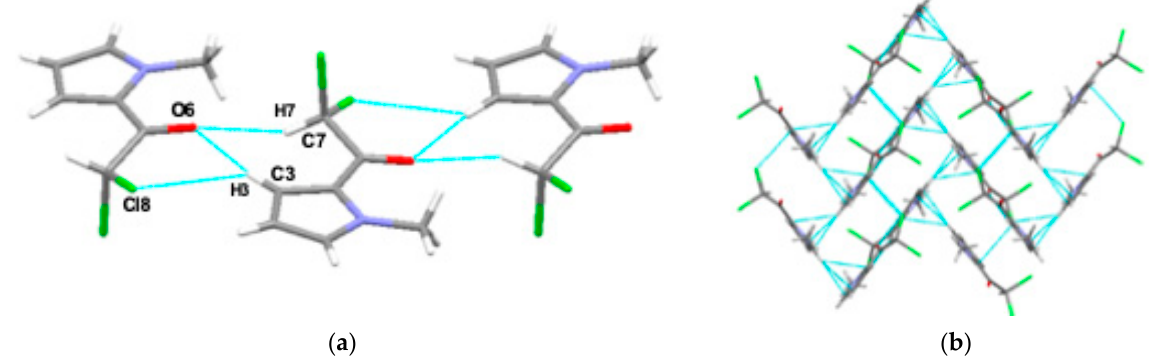
III Figure 3. Full interactions maps for investigated compounds I – III .